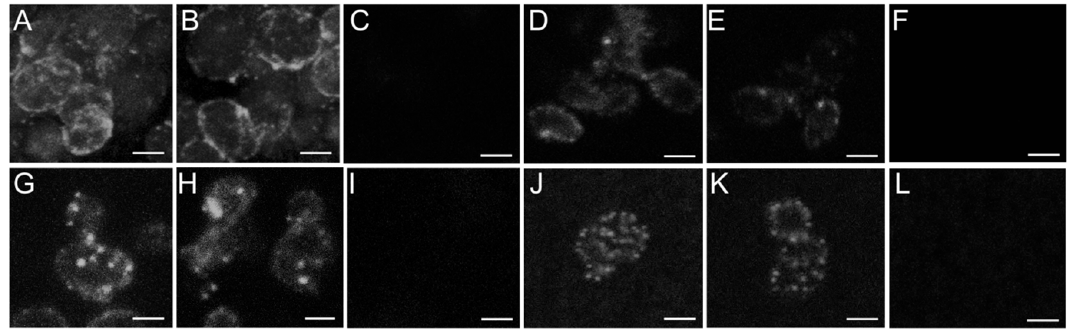
Figure 5. Immunofluorescence microscopy of Saccharomyces cerevisiae cells and cell walls stained with antibodies against Bgl2. Scale bars correspond to 2 µm. Cells ( A – C ). CW with ( D , E ) and without ( F ) EDC crosslinking and boiled in 3% SDS. CW before ( G – I ) and after ( J – K ) Tris extraction. Control samples from bgl2 Δ strain ( C , I , L ).